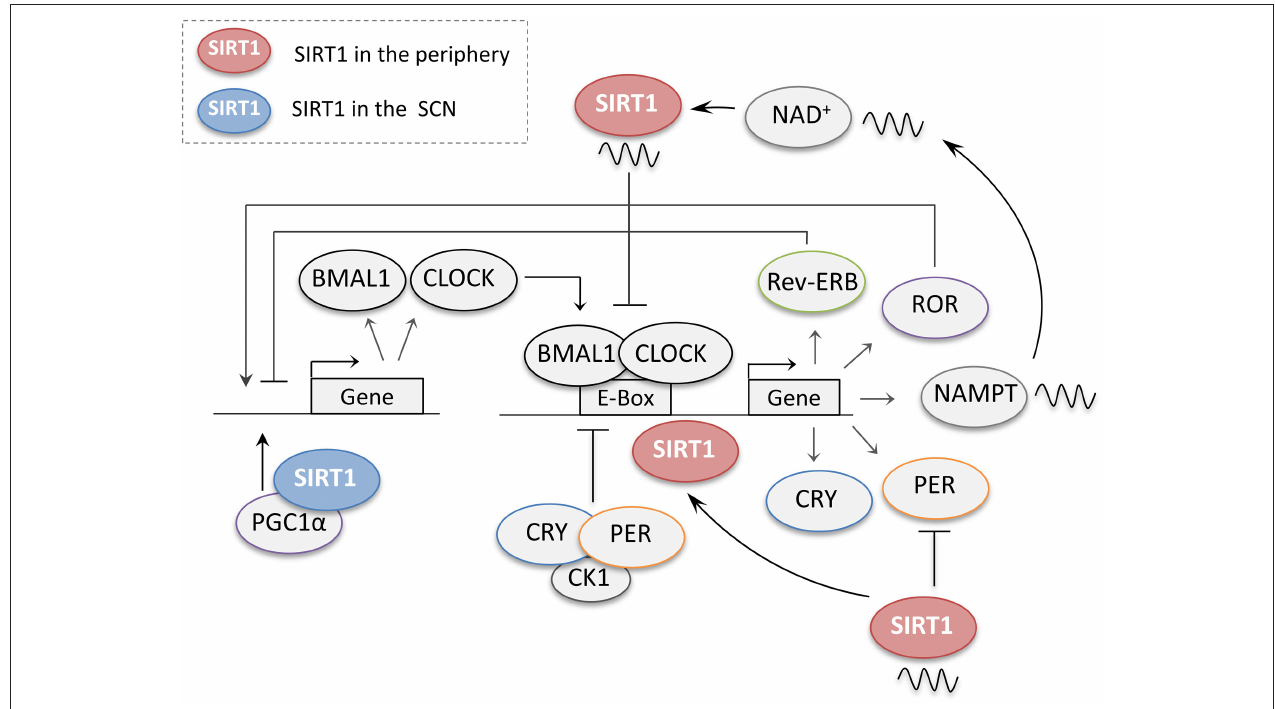
FIGURE 4 | The regulation of central and peripheral clock genes by SIRT1. When dimerized, the core clock genes CLOCK and BMAL1 promote the expression of several downstream genes including their own negative regulators periods (PER) and cryptochromes (CRY). PER and CRY accumulate during the day and together with casein kinase 1 (CK1) then repress their own transcription. The CLOCK-BMAL1 complex also regulates the retinoic acid-related orphan receptors (ROR) and the nuclear receptors (Rev-Erb), which compete for the regulation of the BMAL1 promoter. In the peripheral clocks, SIRT1 regulates the circadian genes at different levels. SIRT1 protein levels cycle in a circadian manner, and through its rhythmic binding to the CLOCK-BMAL1 complex SIRT1 promotes the circadian transcription of Bmal1, Ror γ , Per2, and Cry1. SIRT1 also promotes the deacetylation and degradation of the PER2 protein. SIRT1 activity has also been reported to cycle in a circadian manner owing to the rhythmic expression of NAMPT, a crucial enzyme for NAD + biosynthesis, by the CLOCK-BMAL1 complex. In turn, SIRT1 also acts as a negative regulator of the CLOCK-BMAL1 complex thus preventing the activation of circadian promoters. In the suprachiasmatic nucleus (SCN), SIRT1 activates the transcription of the circadian genes BMAL1 and CLOCK through PGC-1 α